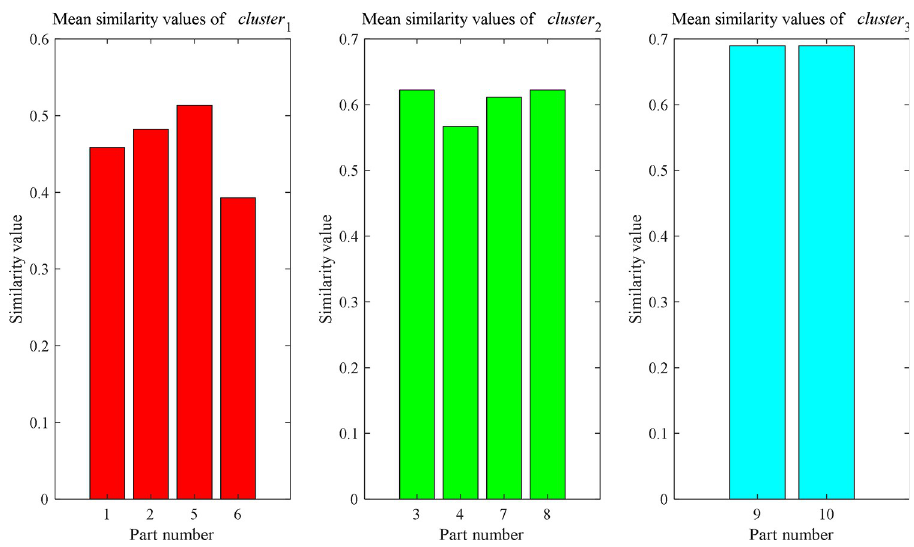
Fig 6. The mean similarity calculation results of each category.